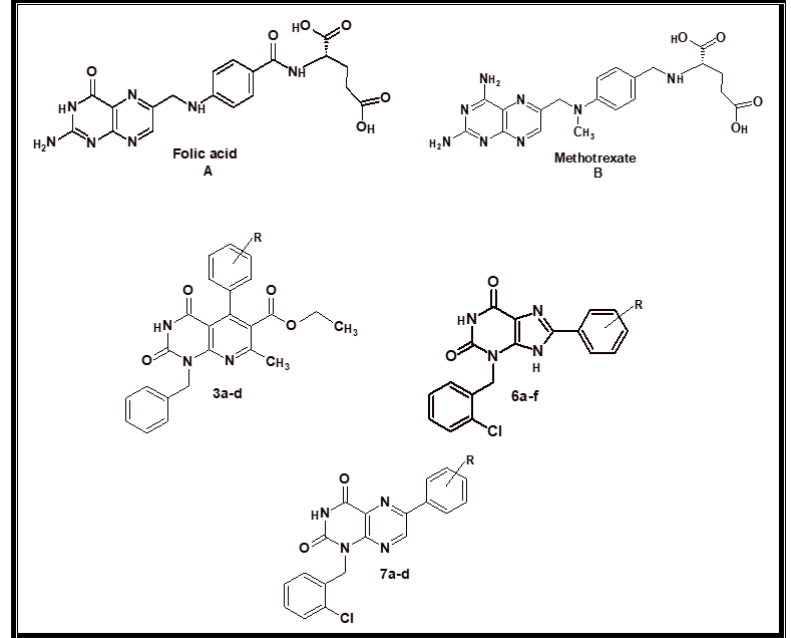
Figure 1. Structure of folic acid, methotrexate and the proposed derivatives.